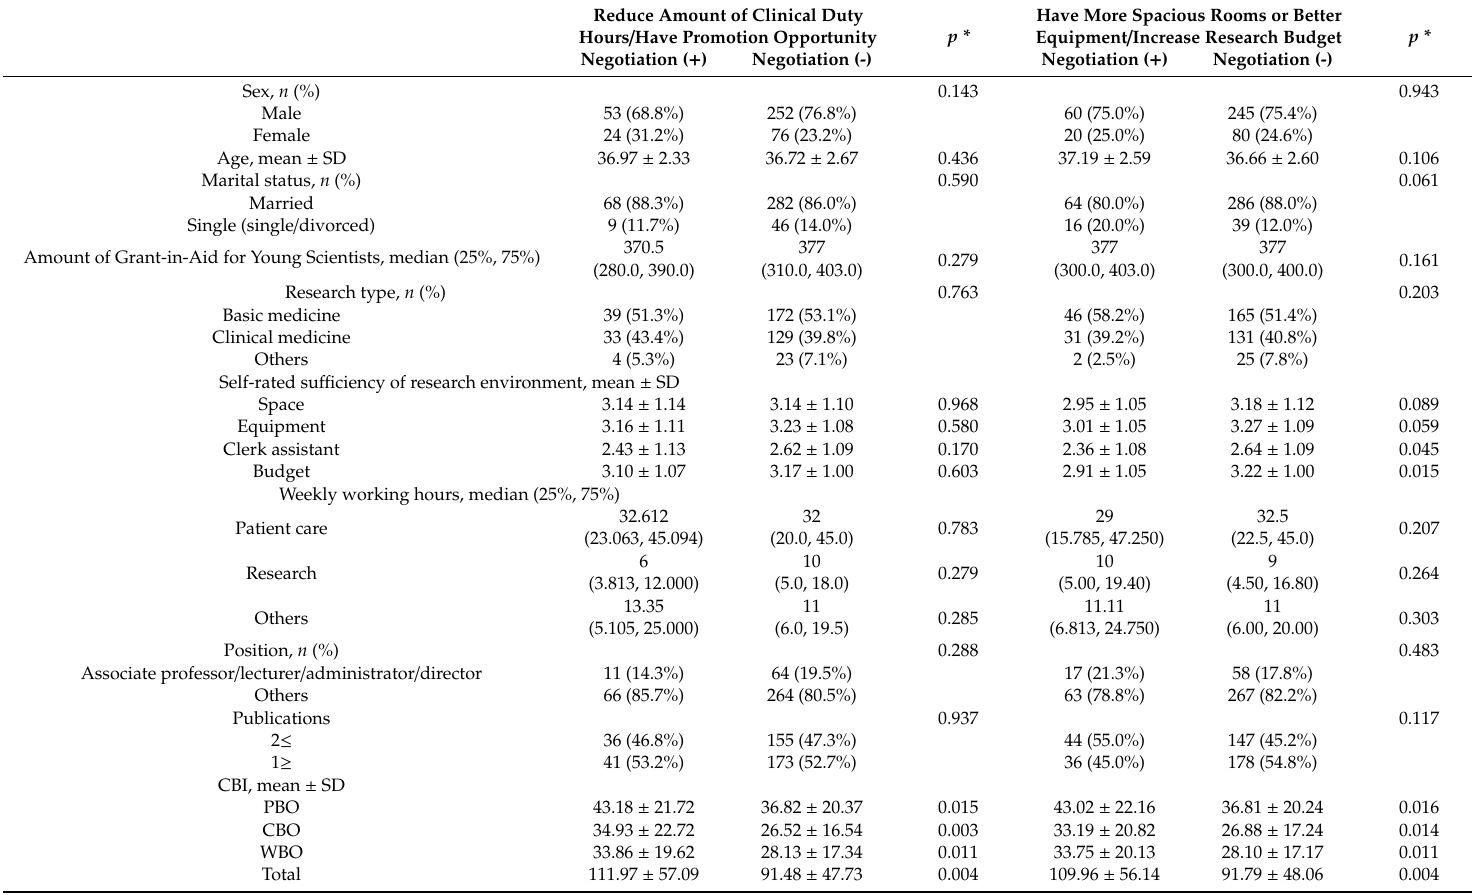
Table 2. Characteristics of KAKENHI-awarded young physician researchers who did or did not have the two types of negotiation experiences.